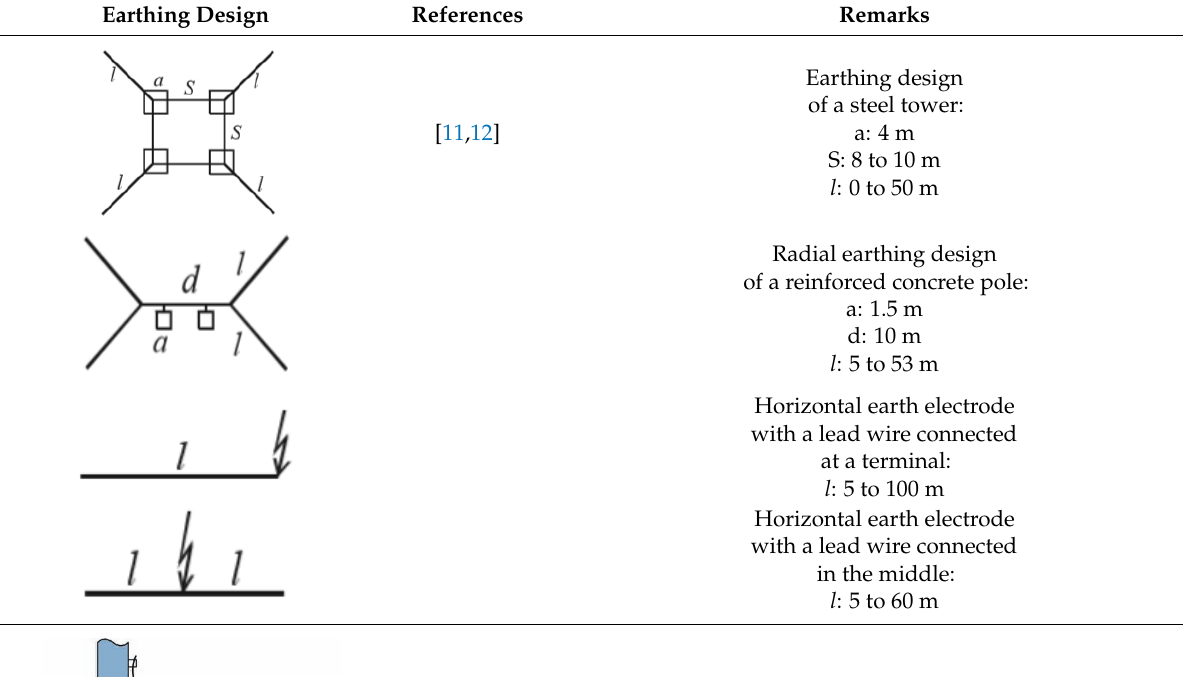
Table 1. Current practice of earthing design and arrangement in several Asian countries. Countries Earthing Design